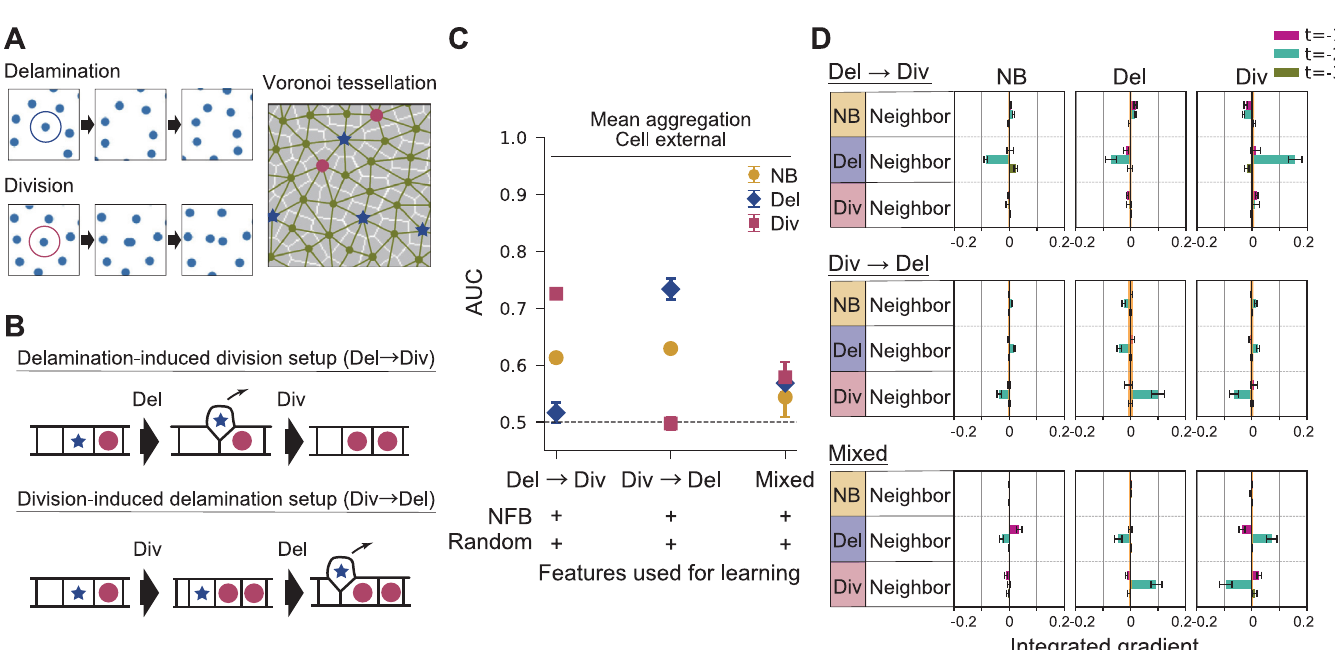
Fig 4. Validation of the GNN approach by in silico models of homeostasis. (A) Snapshots of simulation from the delamination-induced division setup. Cell contacts are defined by the Voronoi tessellation. Delaminating cells and dividing cells are represented by blue stars and red circle markers, respectively. (B) Schematic of the rules applied in in silico models of homeostasis: delamination-induced division, division-induced delamination, and mixed. (C) The AUC of the cell external model with mean aggregation is shown for the three in silico setups, obtained by averaging over six trained models. Error bar: standard deviation. (D) The attribution of the cell external model with mean aggregation is shown for three in silico setups. The IG averaged over six trained models is shown for each pooled feature. Error bar: standard error. The upper and lower values of the IG of the random feature are shown as the orange zone.